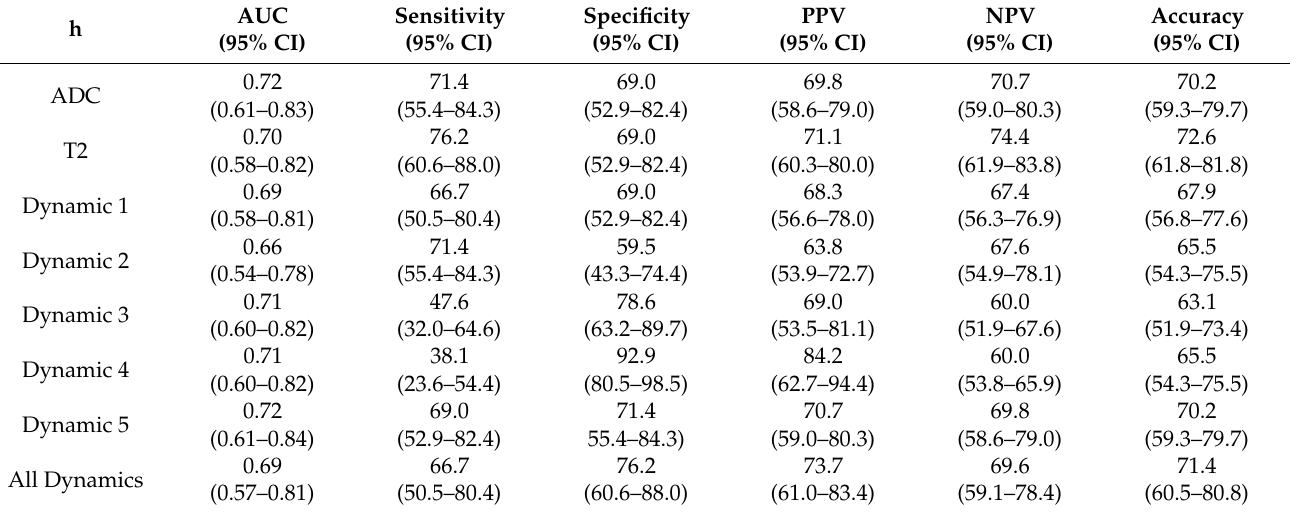
Table 2. Best mean classification accuracies achieved for the prediction of pCR based on each MRI imaging sequence as well as in combination with PET for prediction of pCR in the entire